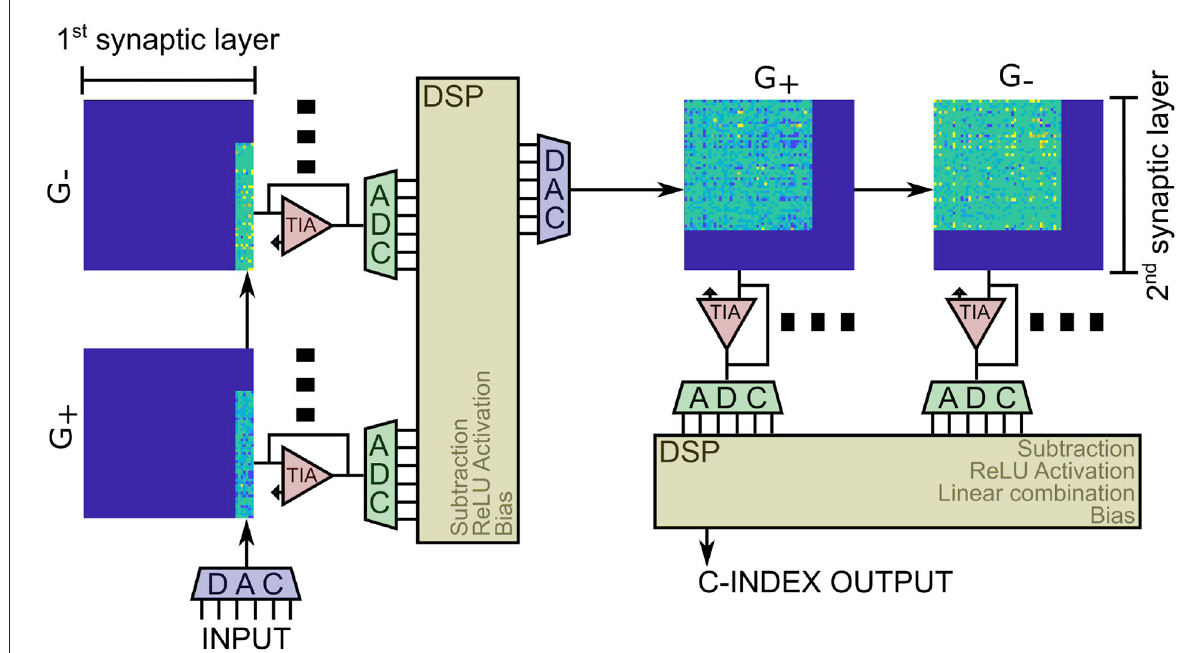
FIGURE7 RRAM-based implementation of the DeepSurv neural network considering the 64 × 64 crossbars studied in this work. The additional circuitry, such as ADCs, DACs, and DSPs, required for the operations outside the MVMs are highlighted as